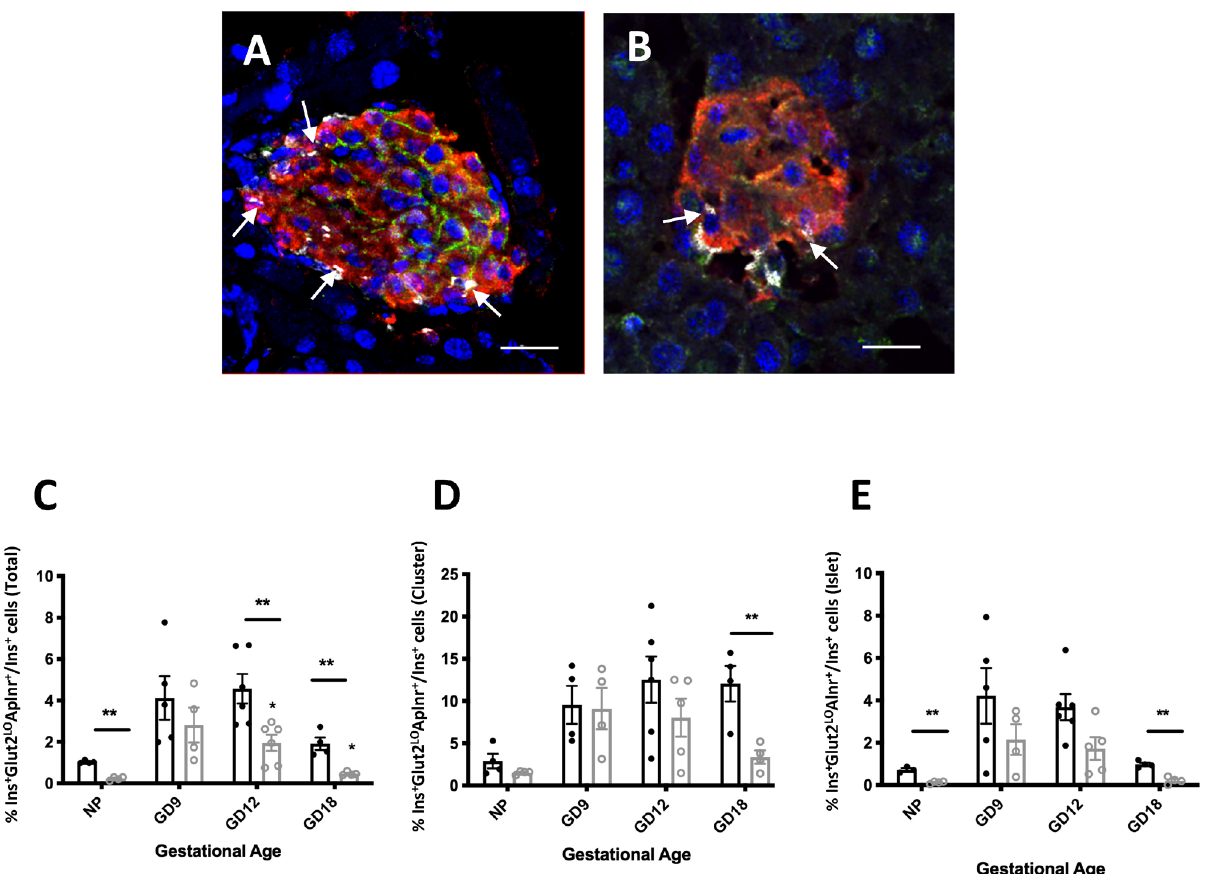
Figure 4. Immunohistochemical localization of Aplnr (white), insulin (red), Glut 2 (green) and cell nuclei (DAPI, blue) in islets from pregnant mice at GD 12 exposed in early life to control ( A ) or LP ( B ) diet. Co-localization of Aplnr to Ins + Glut2 LO cells is indicated by arrows. Bar represents 80 µm in ( A ) and 50 µm in ( B ). The percent Ins + Glut2 LO Aplnr + cells relative to all Ins + cells is shown for total pancreas ( C ), extra-islet clusters ( D ) or within islets ( E ) for control (closed circles, black bars) or LP pregnancies (open circles, grey bars). Values represent mean ± SEM (n = 4–6) in non-pregnant females (NP) or at gestational day (GD) 9, 12 or 18. *p < 0.05, **p < 0.001 vs. control.